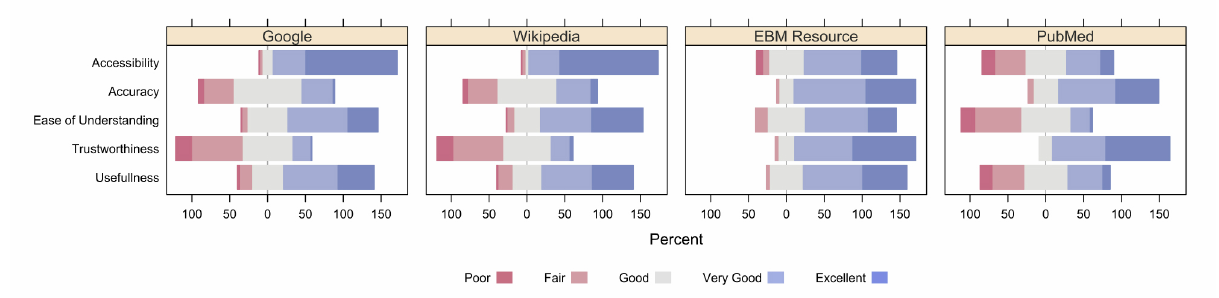
Figure 3. Student evaluations of specified